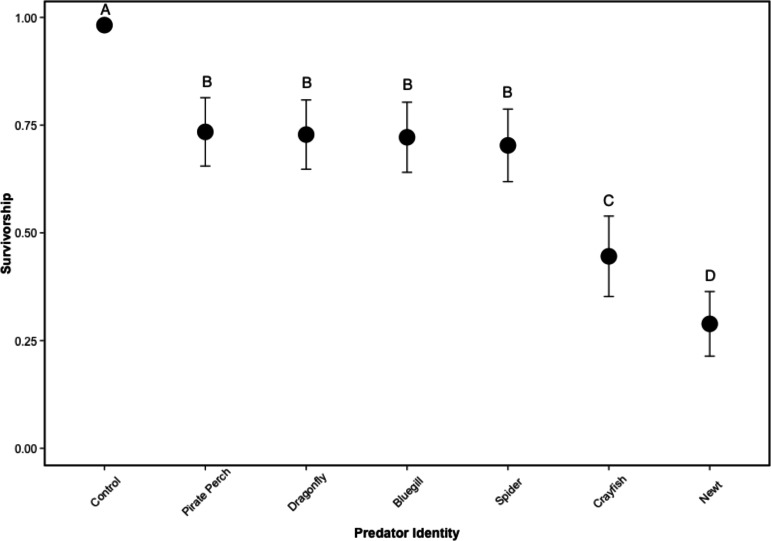
Tadpole survivorship with different predators.The model-generated mean survivorship of Lithobates sphenocephalus tadpoles in lethal predator treatments with 95% confidence intervals (\documentclass[12pt]{minimal}
\usepackage{amsmath}
\usepackage{wasysym}
\usepackage{amsfonts}
\usepackage{amssymb}
\usepackage{amsbsy}
\usepackage{upgreek}
\usepackage{mathrsfs}
\setlength{\oddsidemargin}{-69pt}
\begin{document}
}{}${\chi }_{5}^{2}=127.43$\end{document}χ52=127.43, P < 0.001). Treatments that share the same letter are not significantly different, as determined by false discovery rate corrected post hoc analysis.